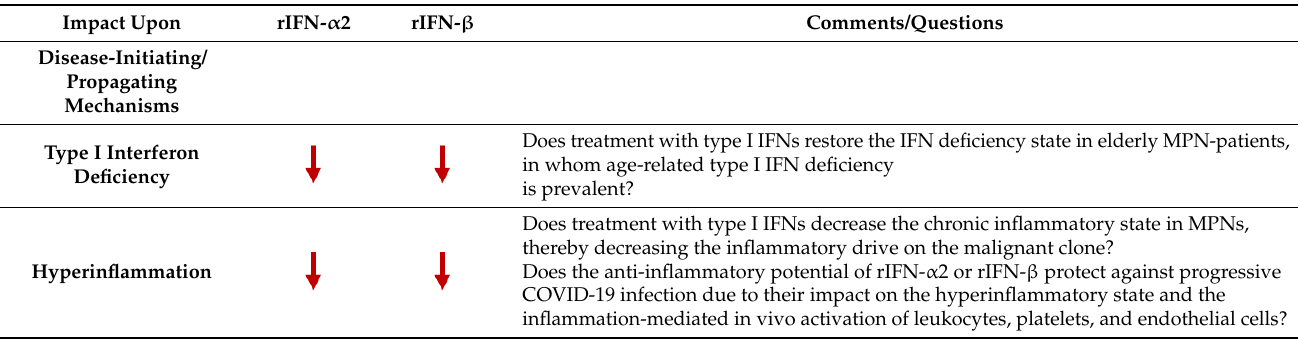
Table 1. Some key questions with regard to the impact of rIFN- α 2 and rIFN- β on clinical, biochemical, and immunological markers in MPNs.